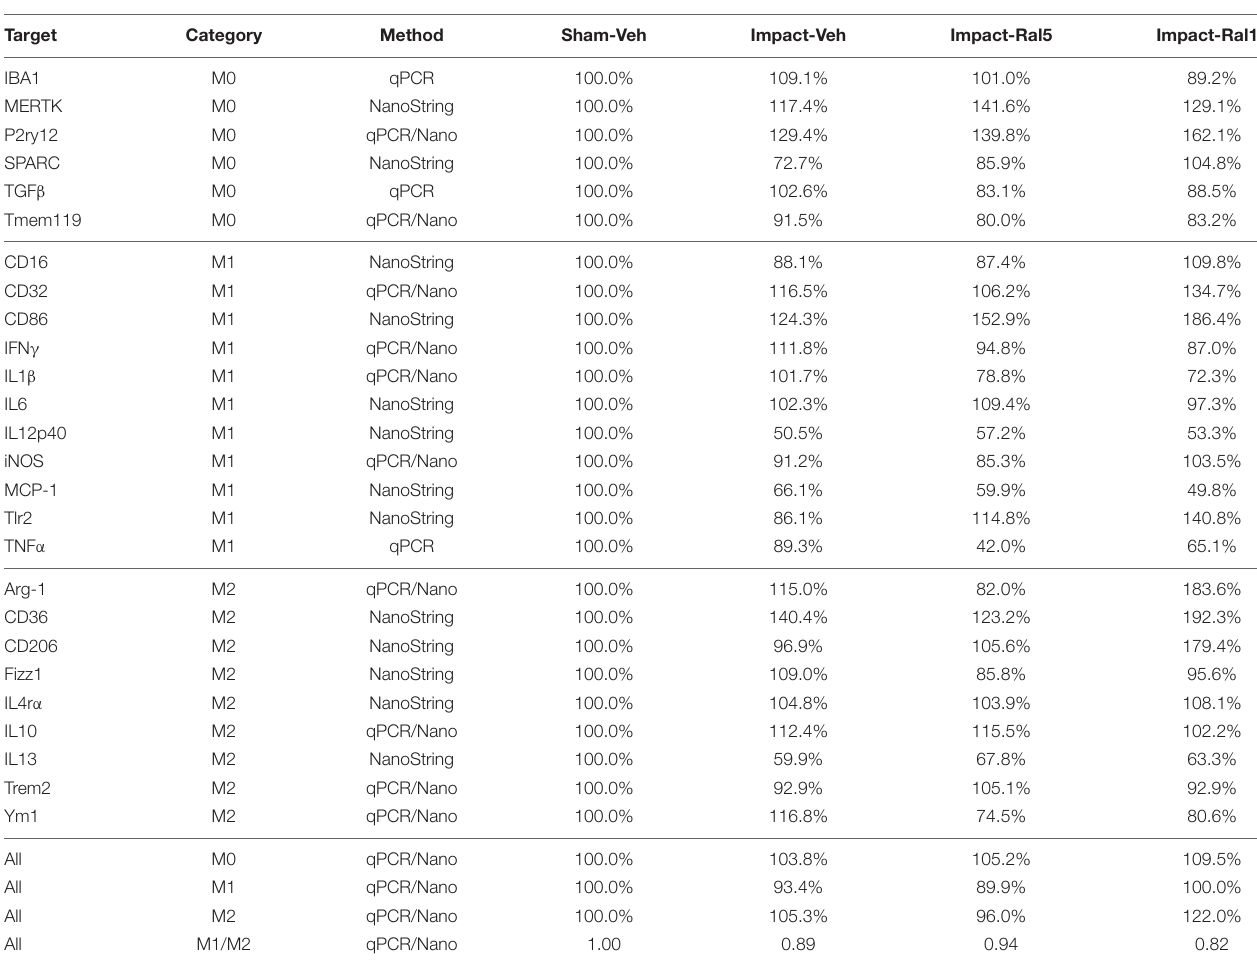
TABLE 5 | Expression of microglial transcripts in